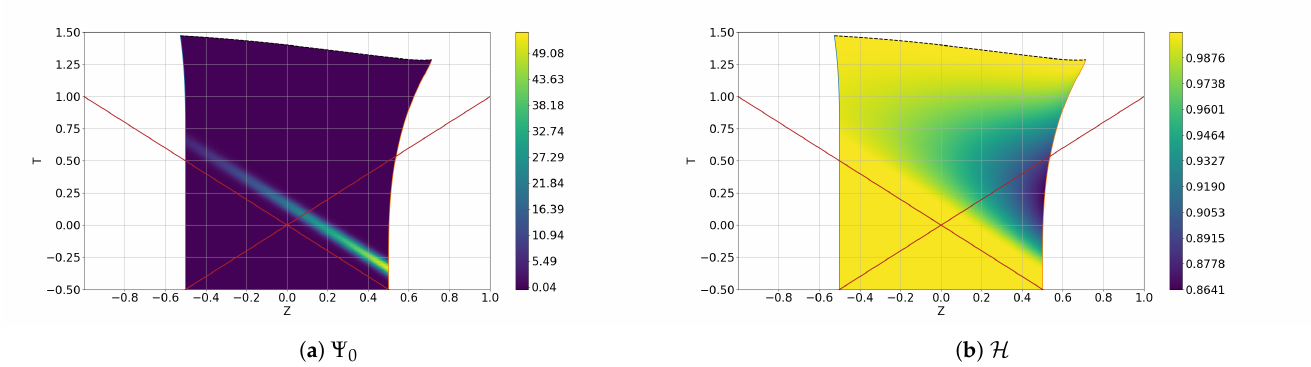
Figure 2. Contour plots of Ψ 0 and H plotted with respect to the semi-invariant T and Z coordinates where a = 1.67. The dashed line represents the last timeslice and the crossed lines are u = 0 and v =